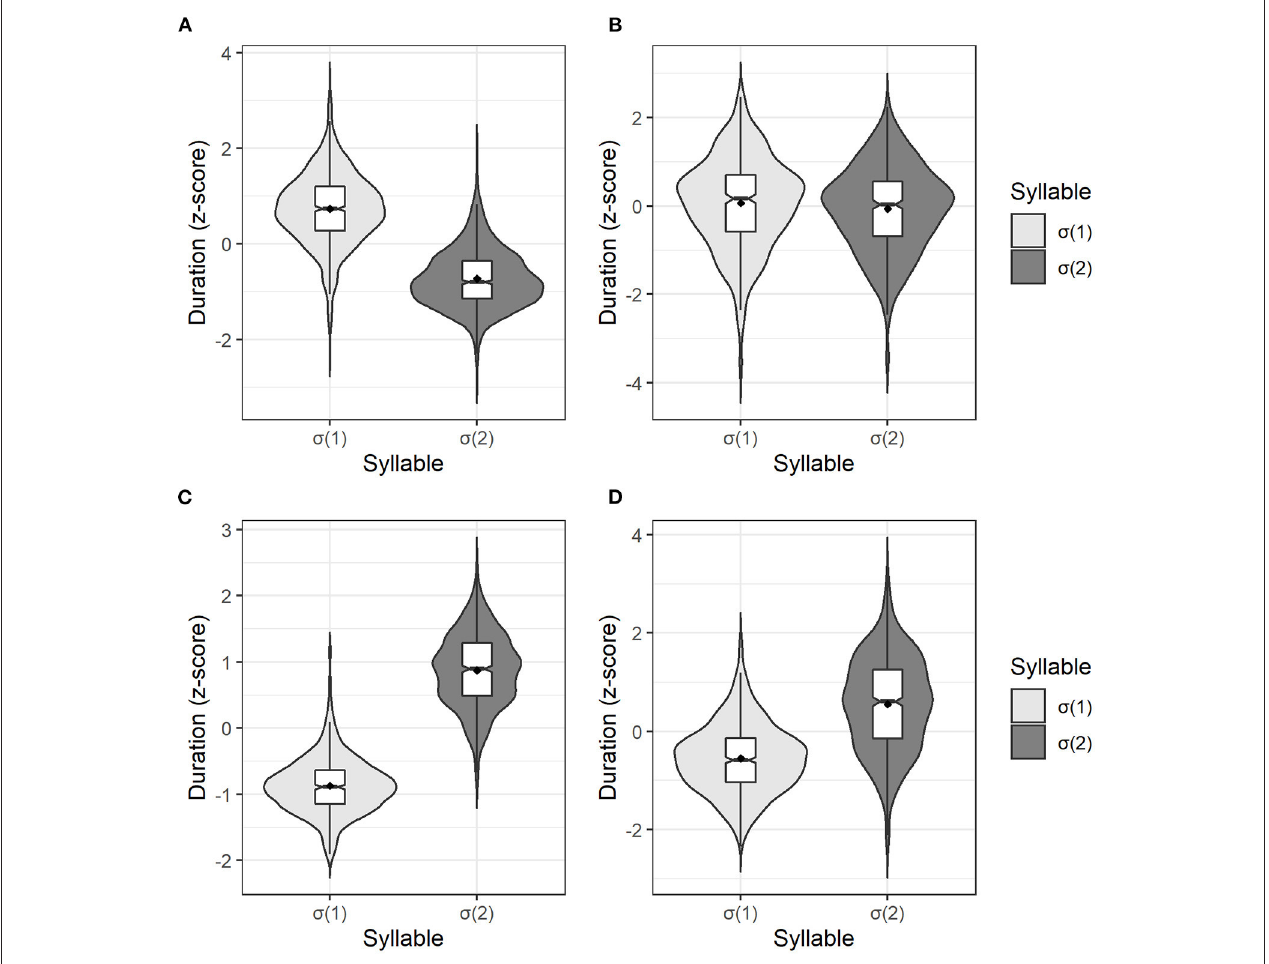
FIGURE 2 | The normalized duration of σ (1) and σ (2) in disyllabic words of Changsha (A) , Chengdu (B) , Fuzhou (C) , and Xiamen dialect (D)